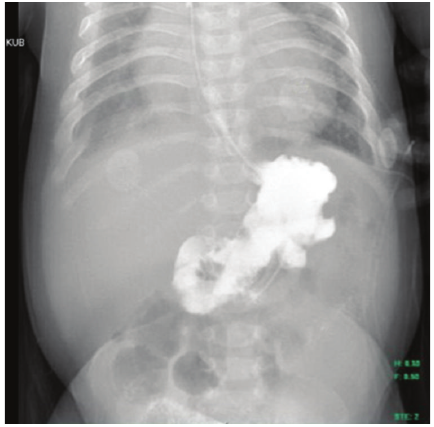
Figure 1: A large ovoid filling defect is noted within the gastric body on this image from an upper gastrointestinal fluoroscopic series.